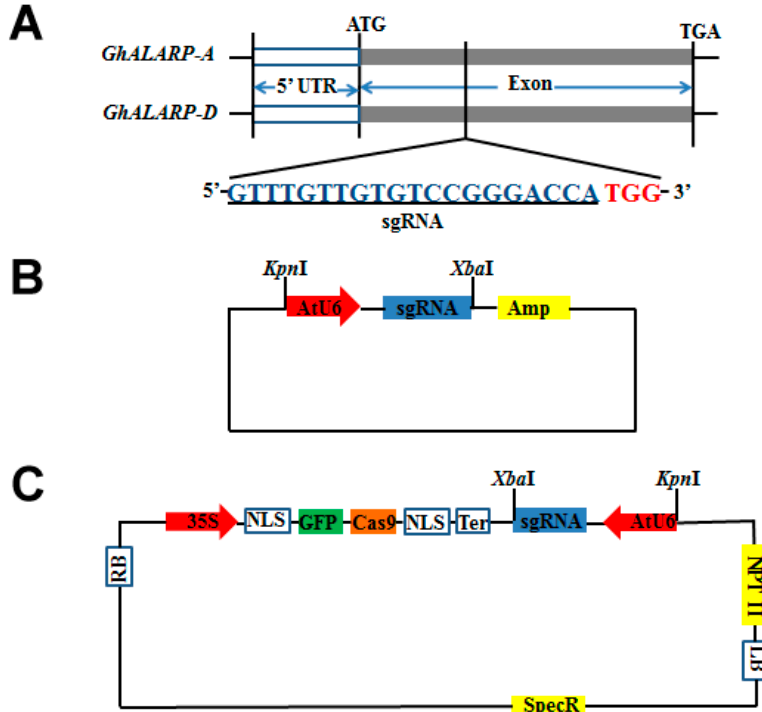
Figure 1. Schematic diagram of the 35S:Cas9/single guide RNA (sgRNA) vector. ( A ) Gene structures of GhALARP-A and GhALARP-D , and the sgRNA sequence (blue nucleotides) targeting both GhALARP-A and GhALARP-D . White boxes indicate 5 (cid:48) -untranslated region (UTR) and the promoter region; gray boxes indicate exons; red nucleotides indicate the protospacer adjacent motif (PAM) sequence; ( B ) Composition of the AtU6 -sgRNA vector. AtU6 , promoter of the U6 gene of Arabidopsis thaliana ; ( C ) Genetic map of the 35S:Cas9/sgRNA construct. Two nuclear localization sequences (NLSs) at the N terminal and C terminal of the green fluorescent protein (GFP)-Cas9 were originated from SV40 NLS-nuclear localization signal (SV40 large T antigen) and nucleoplasmin NLS-bipartite nuclear localization signal (nucleoplasmin), respectively. LB: left border; RB: right border.